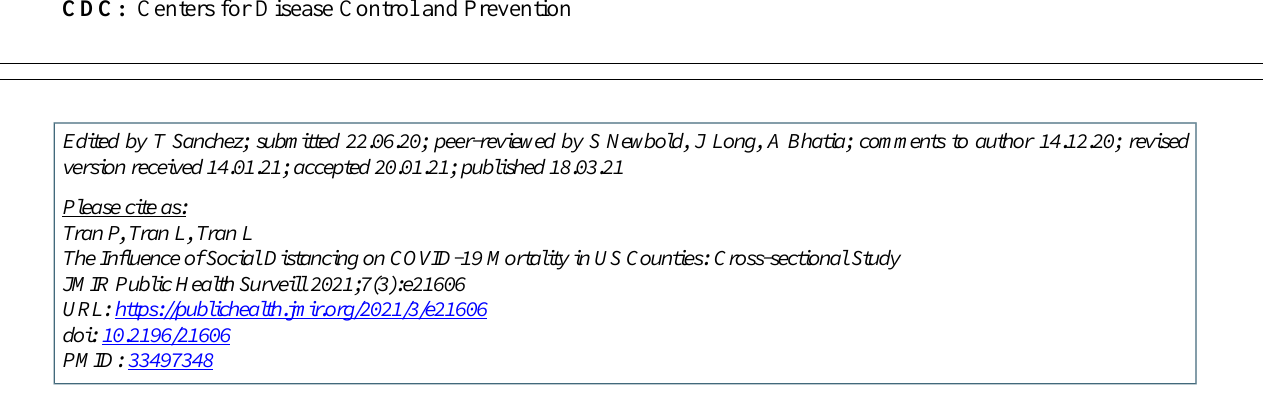
24. Excess Deaths Associated with COVID-19: Provisional Death Counts for Coronavirus Disease (COVID-19). Centers for